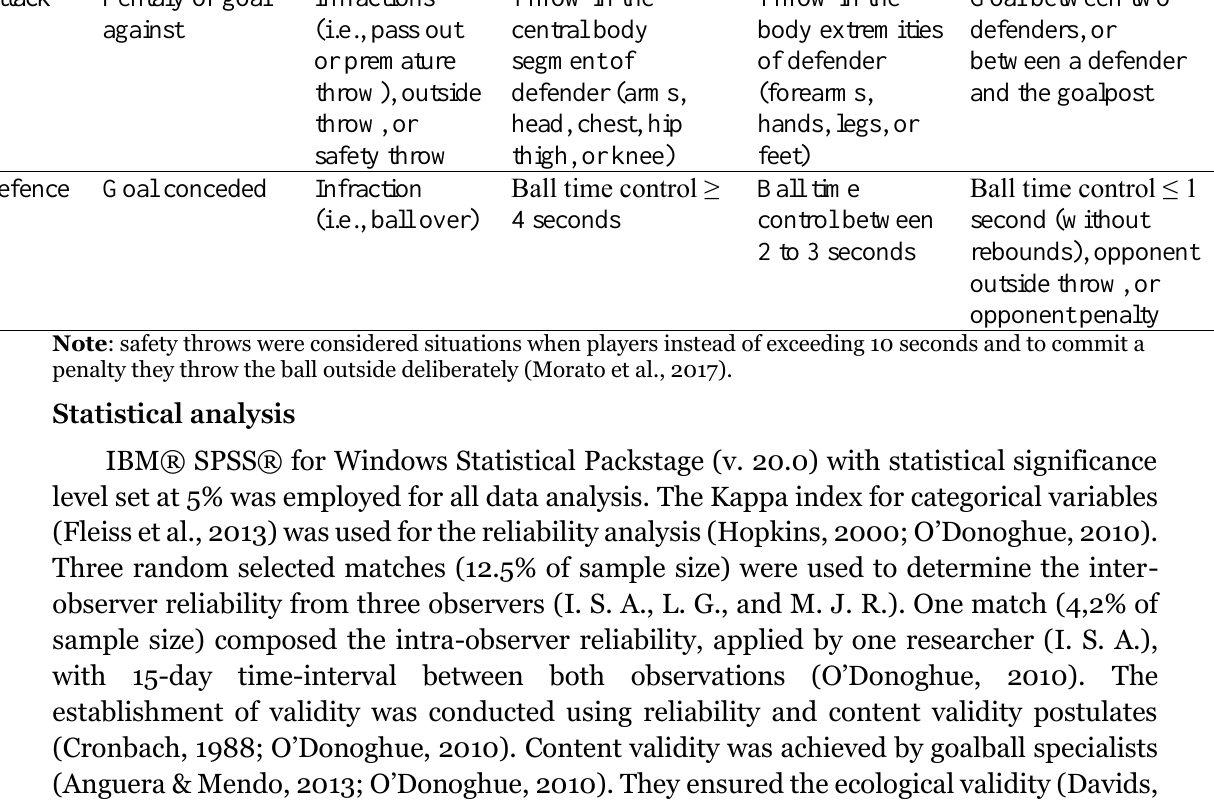
5 Throw in the Goal between two body extremities defenders, or of defender between a defender (forearms, and the goalpost hands, legs, or feet) Ball time Ball time control ≤ 1 control between second (without 2 to 3 seconds rebounds), opponent outside throw, or opponent penalty